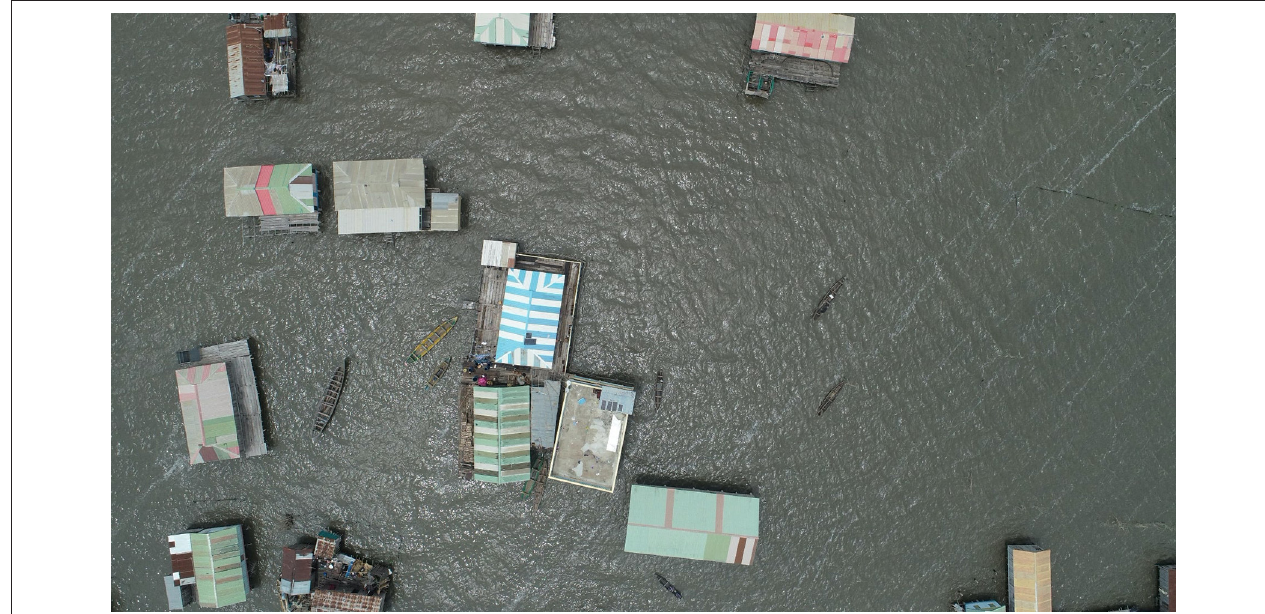
FIGURE 4 | Aerial image of the village of Ganvié on Lake Nokoué. Credit: The Authors.